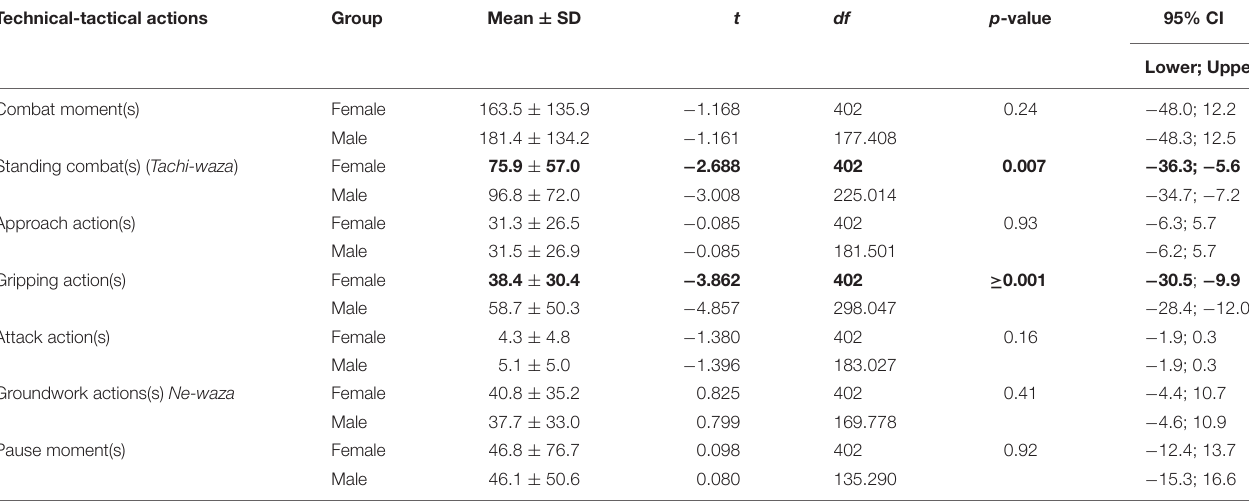
TABLE 1 | Comparisons of behavior judo combat analysis of female versus male cadets (time). Technical-tactical actions